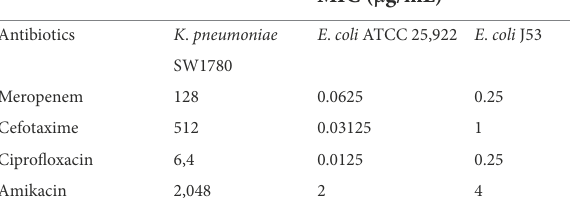
TABLE 2 Minimum inhibition concentrations of four